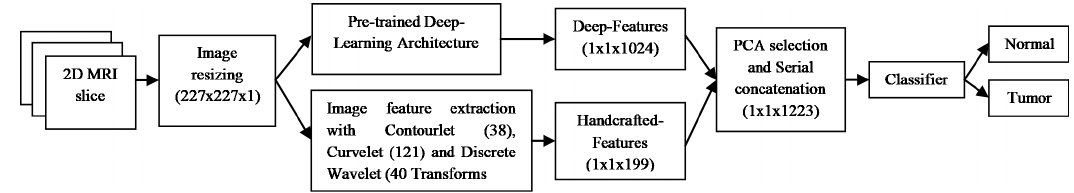
Figure 1. Structure of the customized VGG19 network.